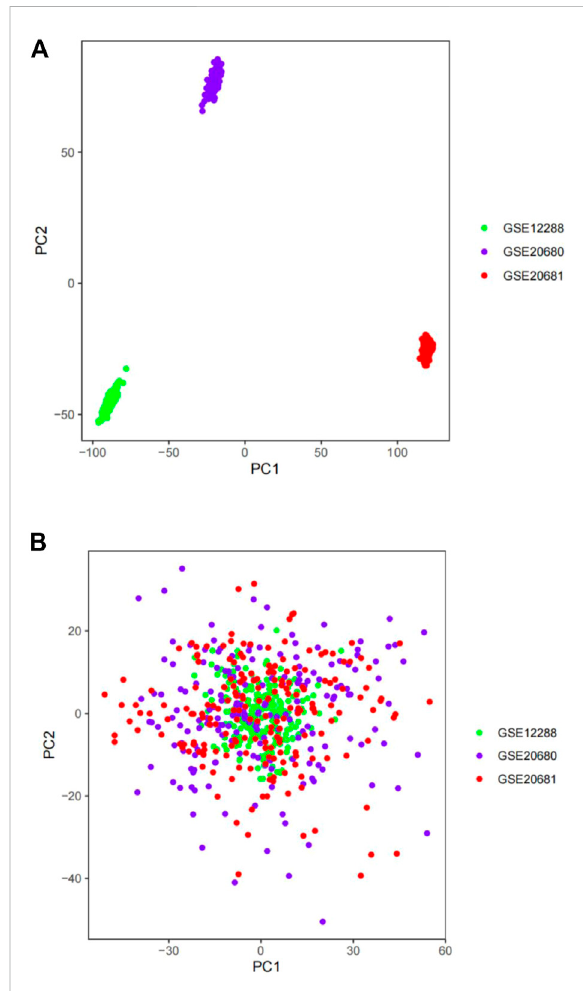
FIGURE 2 The gene expression datasets wereprocessed using principal component analysis (PCA). The top two principal components (PC1andPC2)ofgeneexpressionpro fi leswerevisualizedaspoints on a scatter plot. Samples were based on data visualized without (A) and with (B) the batch effect removed. The colors indicate samples from three different datasets, which are represented by the